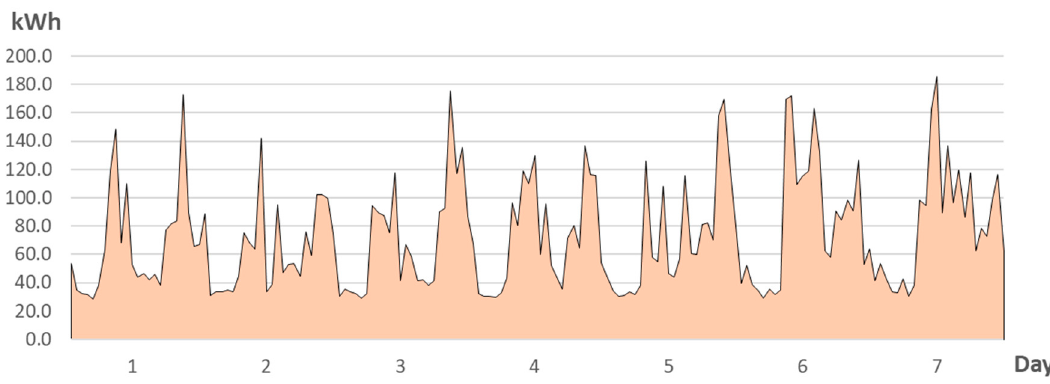
Figure 8. Aggregated hourly energy consumption of the energy community for a typical autumn week. Source: self-elaboration.